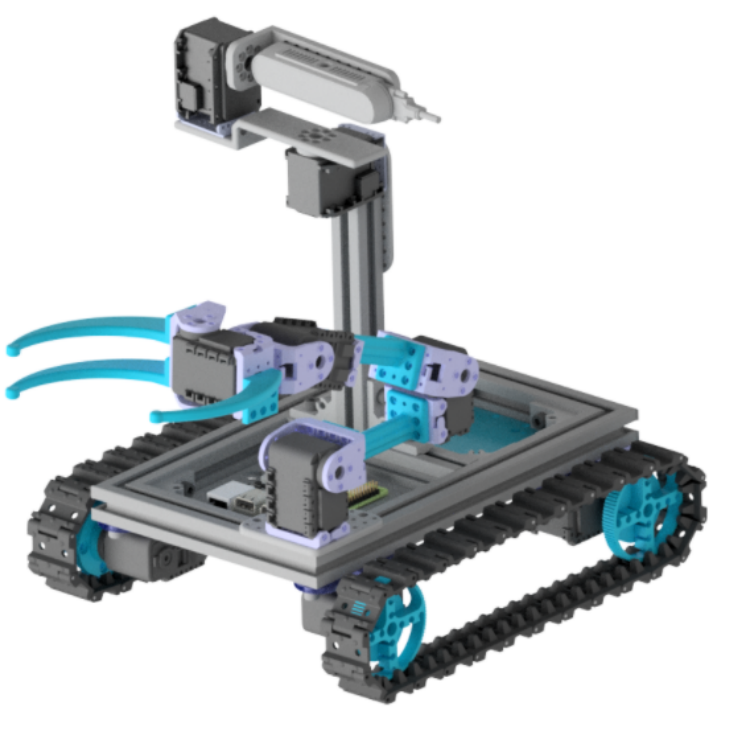
Figure 24. MiniCERNBot educational platform 3D design in its basic configuration. The MiniCERNBot platform is thought to be operated in twins, enabling the execution of cooperative interventions. In addition, they can be plied in a very simple way, by fitting the robot team in a single case, as shown in Figure 25.